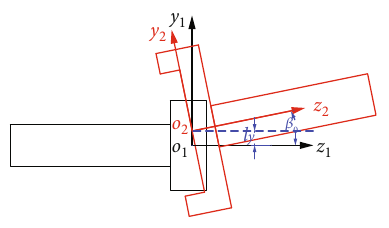
Figure 4: Diagram of the combined